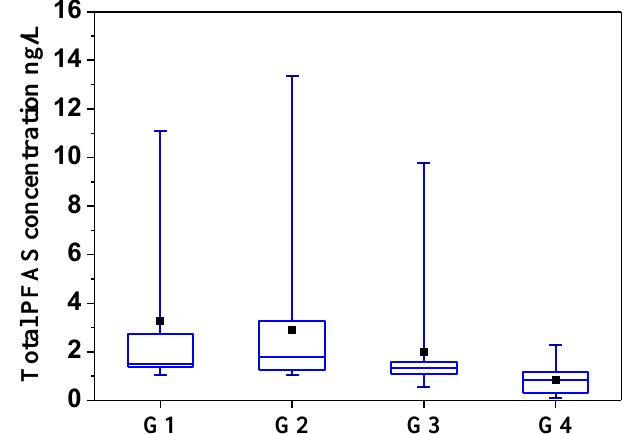
Figure 4. Total concentrations (ng / L) of PFAS in groundwater samples in four regions from the APPHR in Shijiazhuang City.